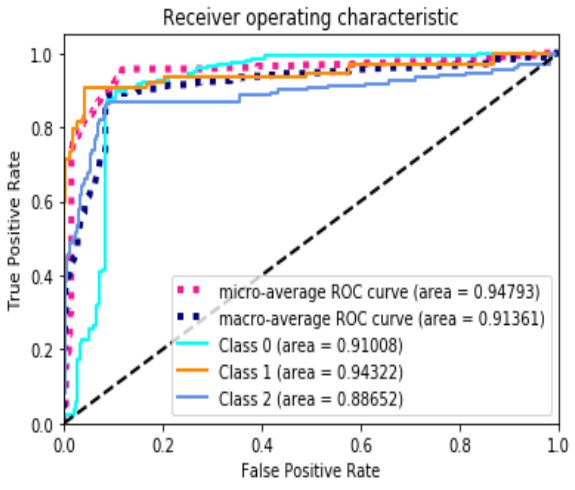
Figure 5. Receiver Operating Characteristic Curve for SVM classifier. Class 0: dormers; class 1: ground; class 2: chimneys.